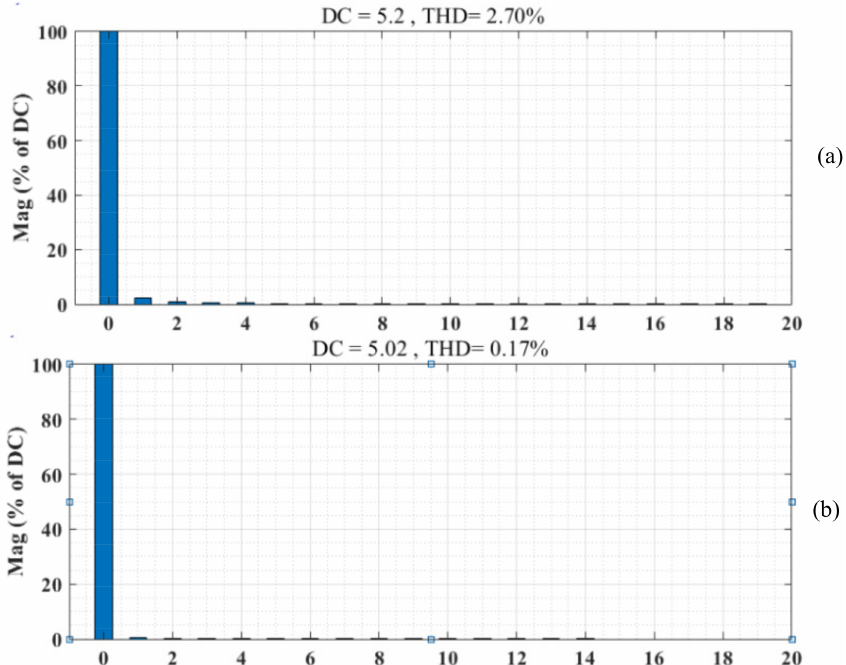
Figure 13. Fast Fourier transform analysis of DC output voltage: ( a ) controlled by the direct power control method; ( b ) controlled by the nonlinear feed-forward PID control method.